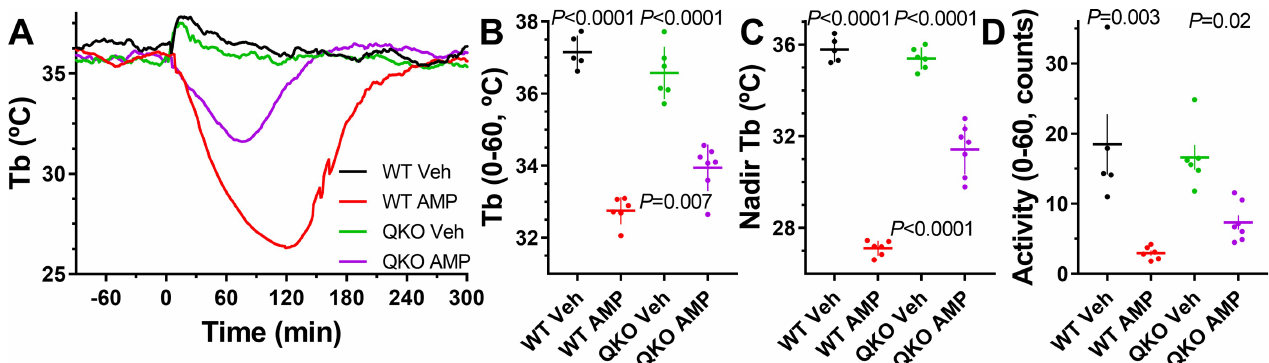
Fig 4. AMP causes less hypothermia in QKO mice compared with controls. Male QKO and control mice were treated with AMP (500 mg/kg, i.p.) or vehicle. Adjusted P values (from two-way ANOVA with Tukey multiple comparisons test; N = 5–7/group) are (top) for effect of vehicle versus AMP within genotype or (bottom) effect of AMP between genotype (S6 Table). The numerical data are in Supporting information. AMP, adenosine 5 0 -monophosphate; i.p., intraperitoneal; QKO, quad knockout; Tb, core body temperature; Veh, vehicle; WT, wild-type.